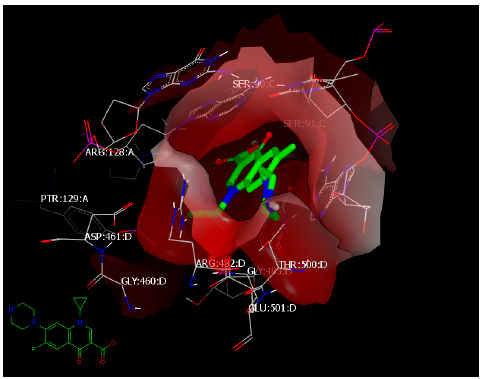
Figure 6. Visual representation of ciprofloxacin docked with 5BTC, showing hydrophobic–hydrophobic interaction and hydrogen bonding with ARG 128:A, as shown by Vida.